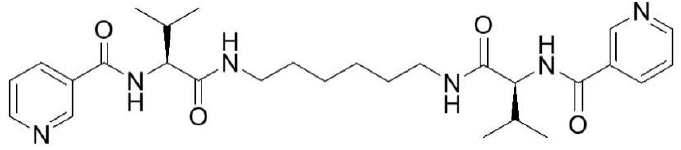
Figure 1. Structure of the compound M6.